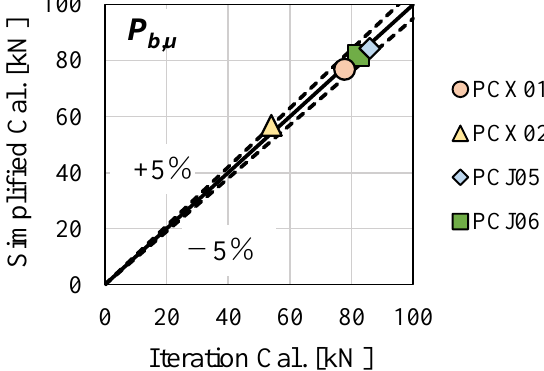
Figure 15. Evaluation accuracy of P b , u by simplified method without correction.